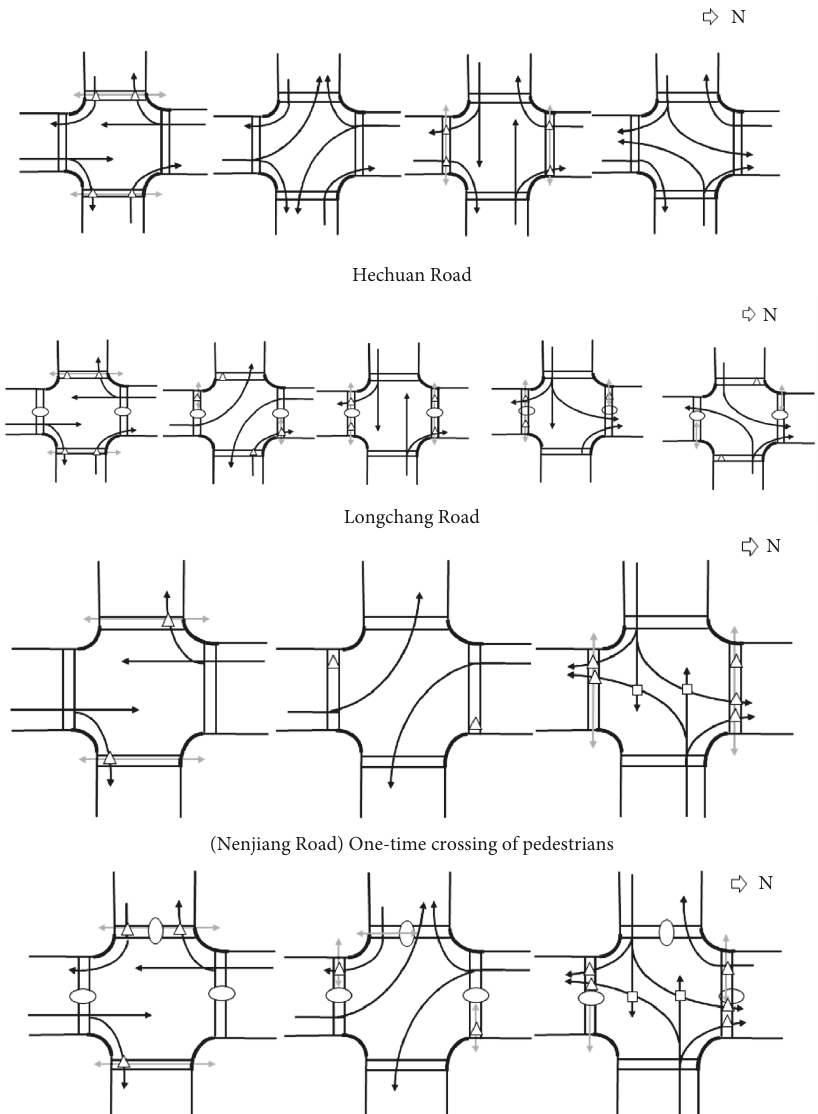
Figure 10: Phase sequence of the